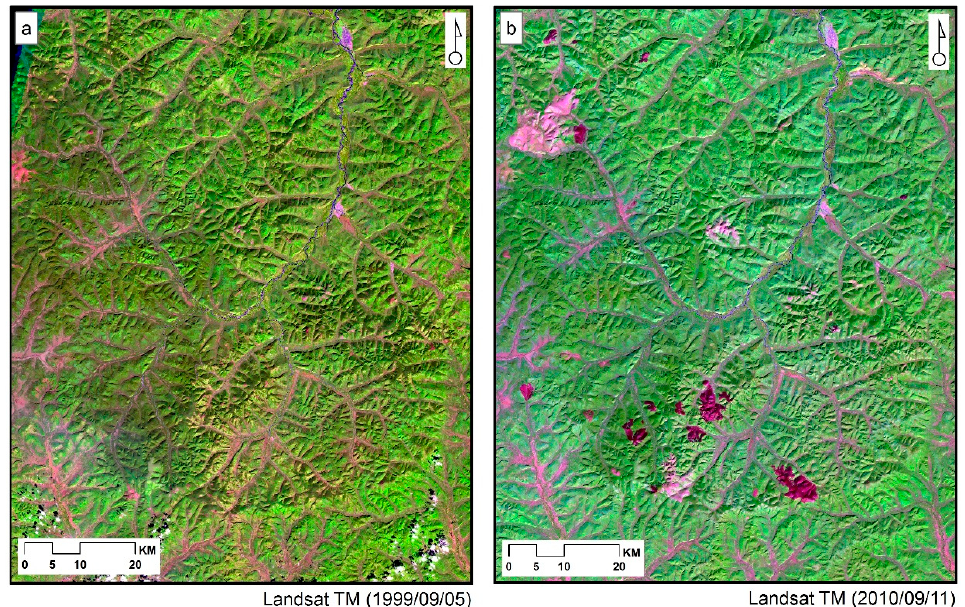
Figure 2. Pre-fire ( a ) and post-fire ( b ) false color Landsat TM images (R-TM5, G-TM4, and B-TM3) of the study area. The light pink patches in ( b ) indicate fires occurred in 2000, while dark red patches indicate fires occurred in 2010.